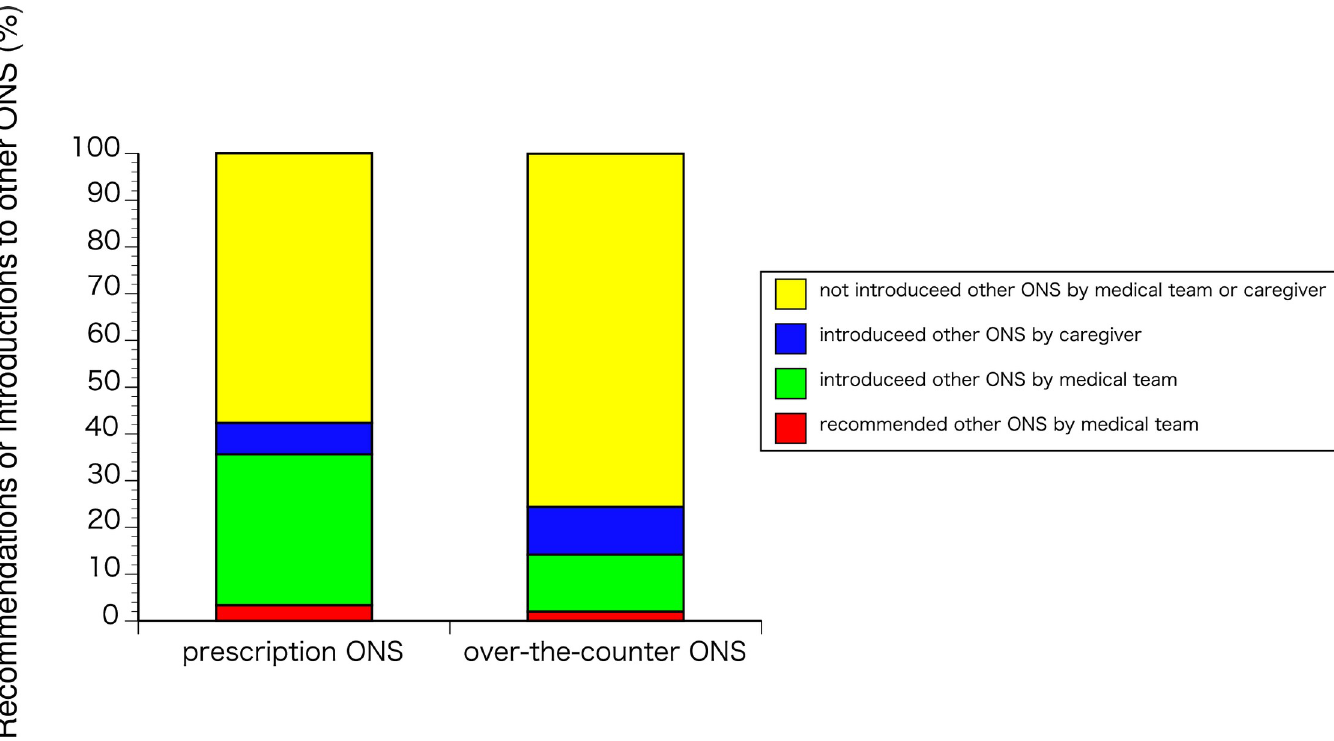
Fig 8. Recommendations or introductions to other ONS. Prescription ONS (n = 59) and Over-the-counter ONS (n = 49).